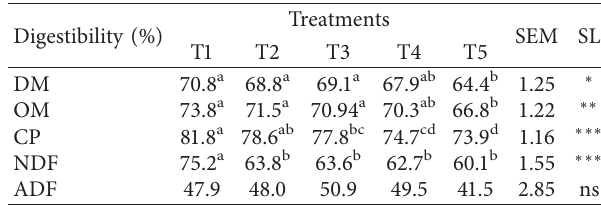
Table 4: Percentages of apparent DM and nutrient digestibility of experimental diets fed to growing Bonga lambs with Rhodes grass hay basal